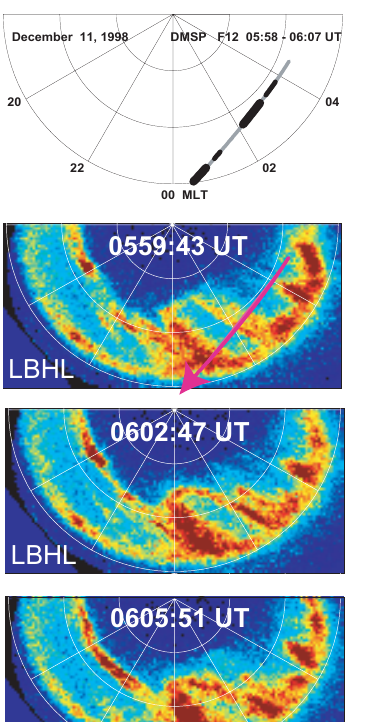
some signatures of upward FA current could be noticed, but it does not show the 1-D properties. In this case the type II precipitation is also seen on the dusk side of the equatorward convection